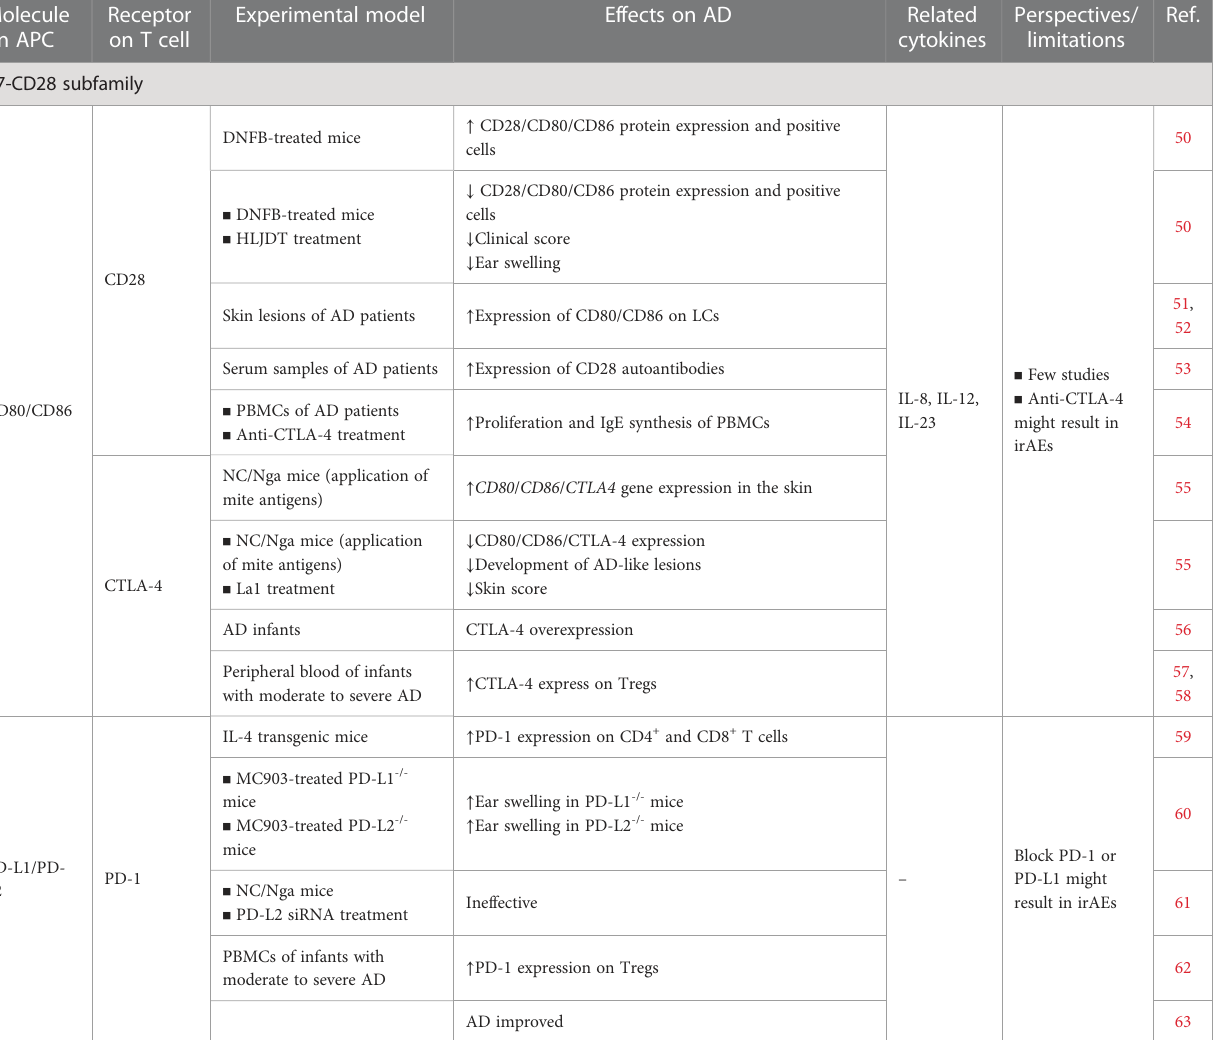
TABLE 1 Preclinical and clinical studies on T cell co-stimulatory and co-inhibitory molecules of the Ig-SF. Molecule Receptor Experimental model Effects on AD Related on APC on T cell